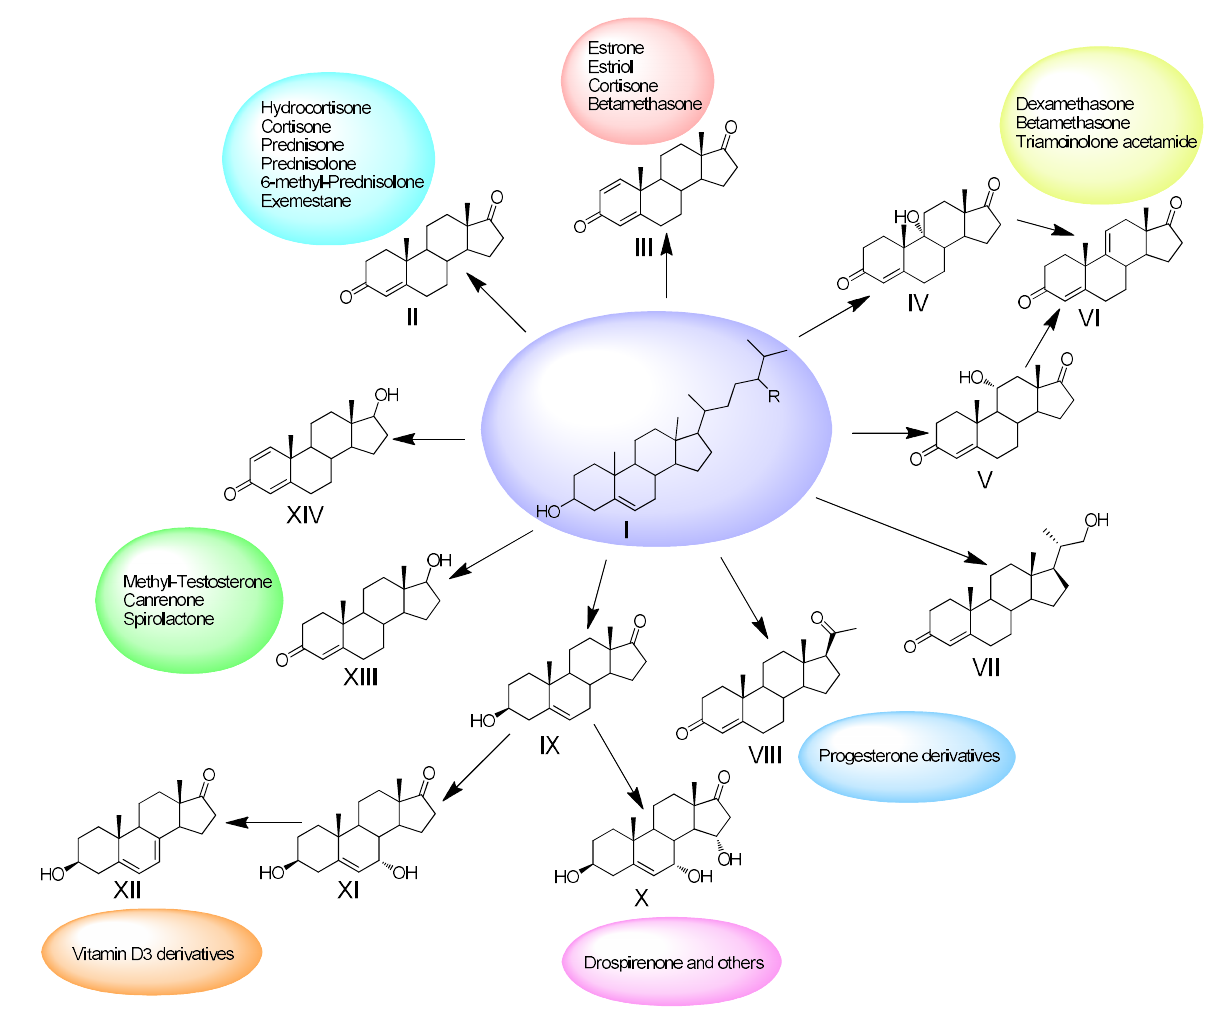
Figure 1. Examples of the steroid synthons produced from phytosterol (I) through microbiological transformations and the pharmaceutical steroids that can be synthesized on their base: